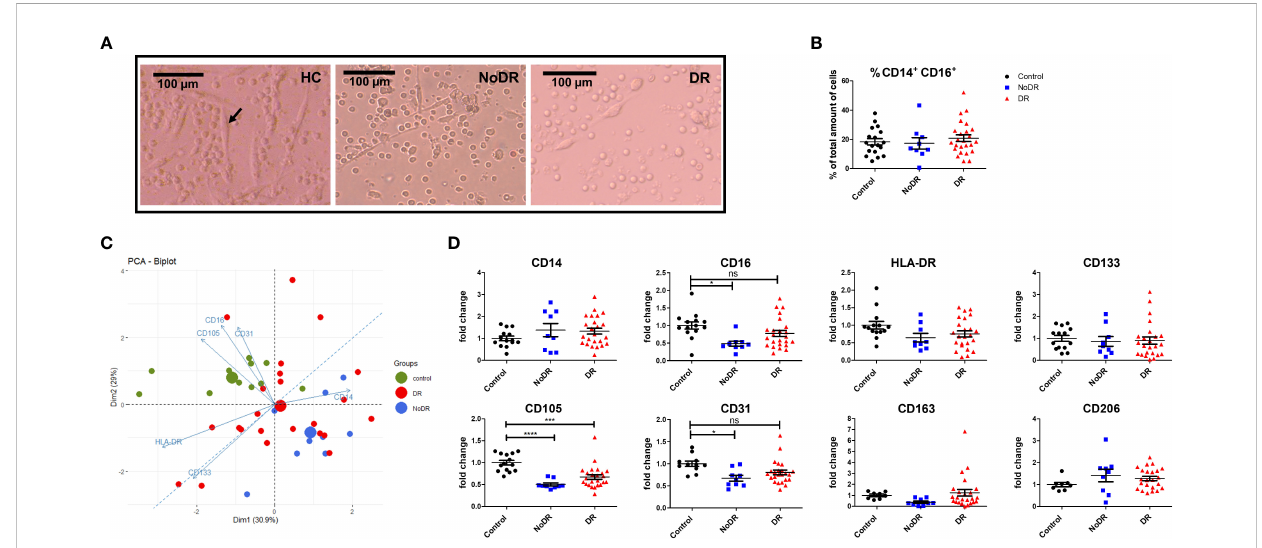
FIGURE 1 PAC from patients with DR display an altered phenotype compared to controls. PBMC were isolated from healthy controls (HC, n = 14), patients with T2DM without retinopathy (NoDR, n = 9), and patients with T2DM with retinopathy (DR, n = 24). Monocytes were stimulated for 4 days to differentiate into PAC. (A) Bright fi eld microscopy of spindle-shaped PAC (arrow) from HC, NoDR and DR patient PBMC, 150× magni fi cation. (B) Percentage CD14 + CD16 + cells, indicating frequency of monocyte-derived cells after culture. (C) Principal component analysis (PCA) biplot based on median fl uorescent intensities (MFI) of CD14, CD16, CD105, CD31, CD133, and HLA-DR as measured on PAC from HC, NoDR and DR patients. Small dots represent each donor, large dots show the average. (D) Individual marker pro fi les of PAC. Values were corrected for auto- fl uorescence by subtracting the backbone control, and normalized to the average of expression by HC PAC. Error bars represent means ± standard error of the mean (SEM). Signi fi cance was calculated using one-way ANOVA and Bonferroni post-hoc test correction for multiple comparisons. ns, non- signi fi cant, *p < 0.05, ***p < 0.001, ****p <